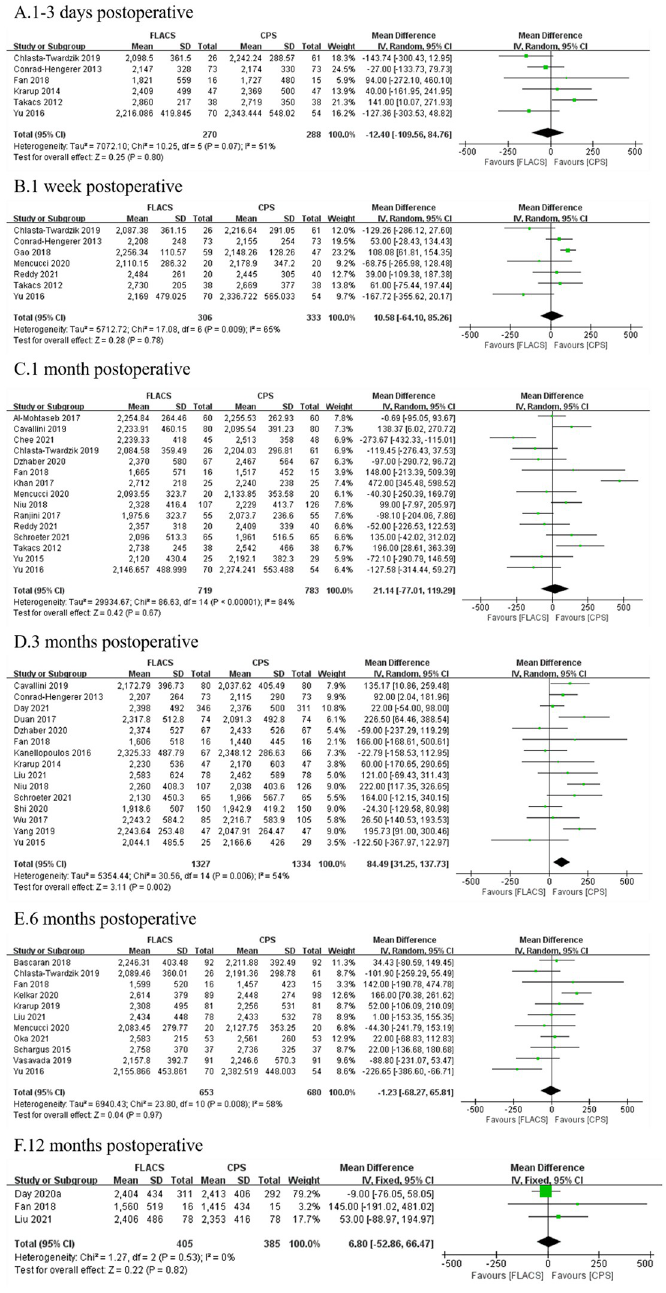
Fig 3. Forest plot of postoperative ECD between FLACS and CPS at A. 1–3 days, B. 1 week, C. 1 month, D. 3 months, E. 6 months, and F. 12 months. Lacking regenerative ability, the total amount of cells was no longer compensated after endothelial cell loss. Instead, migration and enlargement of residual cells occur as a corneal repairing procedure [9]. The remaining cells migrate to the injured area, resulting in a gradual increase in endothelial cell density when measuring at the center of the cornea [12]. This pro- cess takes months [72], therefore, lower ECL% on the first day after surgery indicated less